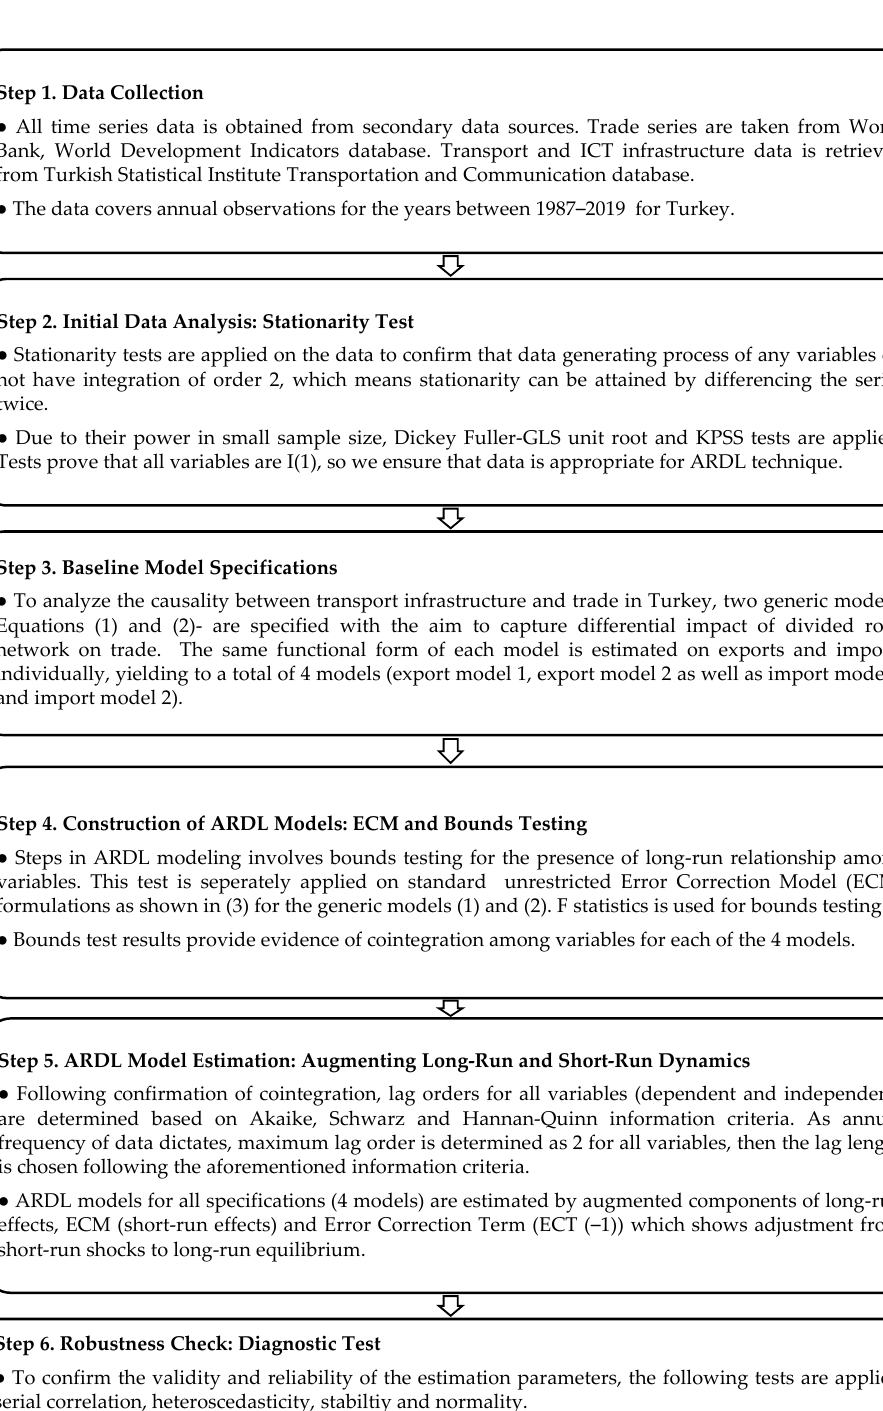
Figure 1. Flowchart for data collection and analytical steps. Exports of goods and services with constant prices (LNEXPORT) and imports of goods and services with constant prices (LNIMPORT) demonstrate the economic indicators on which the effect of infrastructure prevails. Road and railway comprise the land transport system, so total road length (LNROAD), divided road length (LNDIVIDED), railway length (LNRAIL) and mobile cellular subscription per 100 people (LNICT) are used as indicators for transport infrastructure and ICT respectively, on which details are given in Table 2. Secondary data from the World Bank database (trade variables) and Turkish